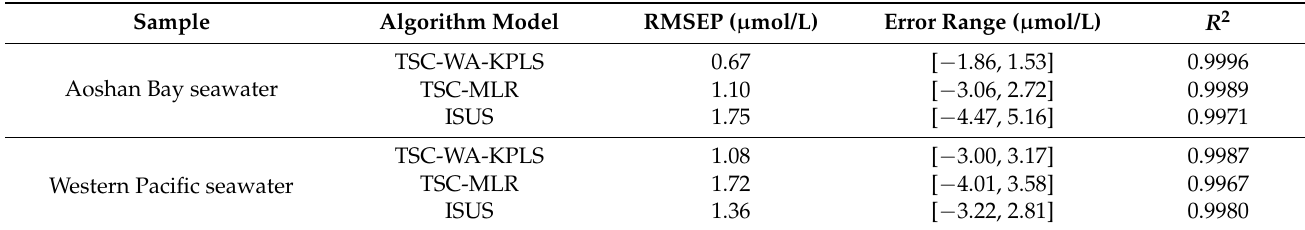
Table 2. Prediction results of different algorithms.